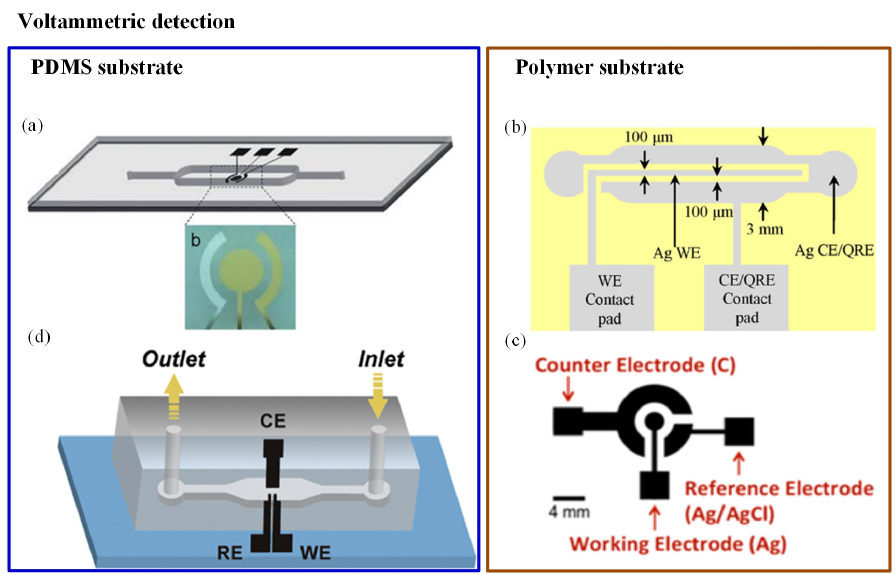
Figure 2. Different orientations of electrodes in electrochemical detection methods: ( a ) Schematic of an Au–Ag–Au electrode integrated with a microfluidic channel to detect Hg +2 [101]; ( b ) illustration of a reusable polymer chip for detection of Pb +2 [99]; ( c ) electrodes printed on a plastic substrate to detect As(III) [102]; and ( d ) single-walled carbon nanotube (SWCNT) electrodes for As(III) detection